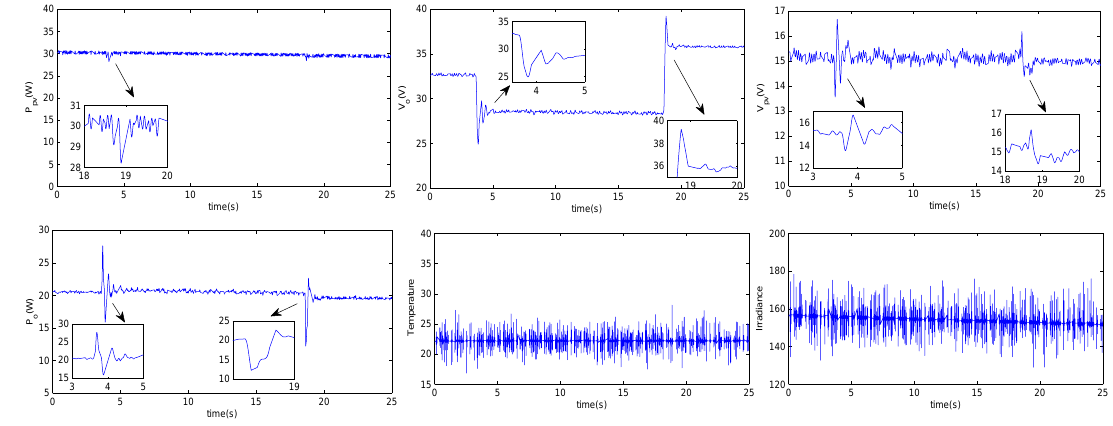
Figure 13. Real behaviors of P o , P pv , V o , and V pv using P&O